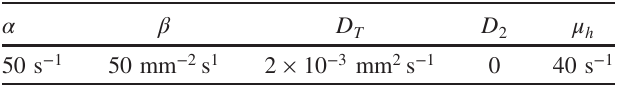
TABLE I. Values of the hydrodynamic coefficients of the colloidal-roller